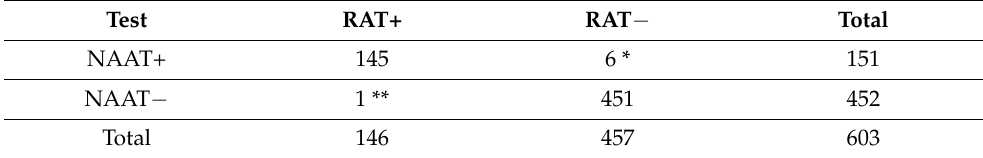
Table 1. NAAT vs. GeneFinder COVID-19 Ag Plus Rapid Test. Test RAT+ RAT − Total NAAT+ 145 6 * 151 NAAT − 1 ** 451 452 Total 146 457